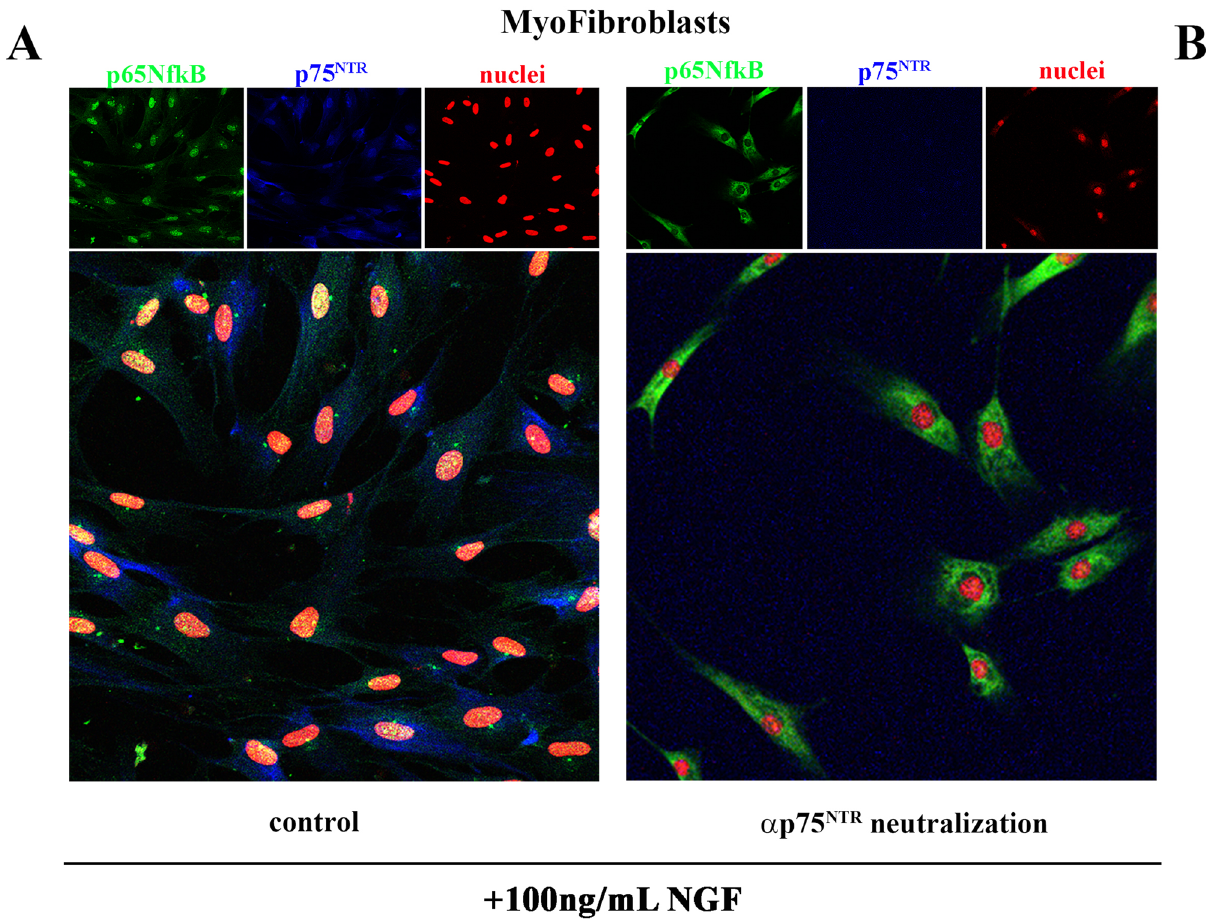
Figure 3. NGF driven p65NFkB expression/localization. Confocal images of p75 NTR siRNA cultures were acquired at 24 h from NGF stimulation. Representative images of p65NFkB (green) and p75 NTR (blue) immunoreactivity over red nuclei (propidium iodide) of 100 ng/mL NGF-exposed myofibroblasts, either untreated ( A ) and p75 NTR oligonucleotides transfected ones ( B ). Upper squares display single staining. Images are representative of three independent experiments acquired under the same channel-series parameters by confocal microscope Nikon c i and analyzed by NIS